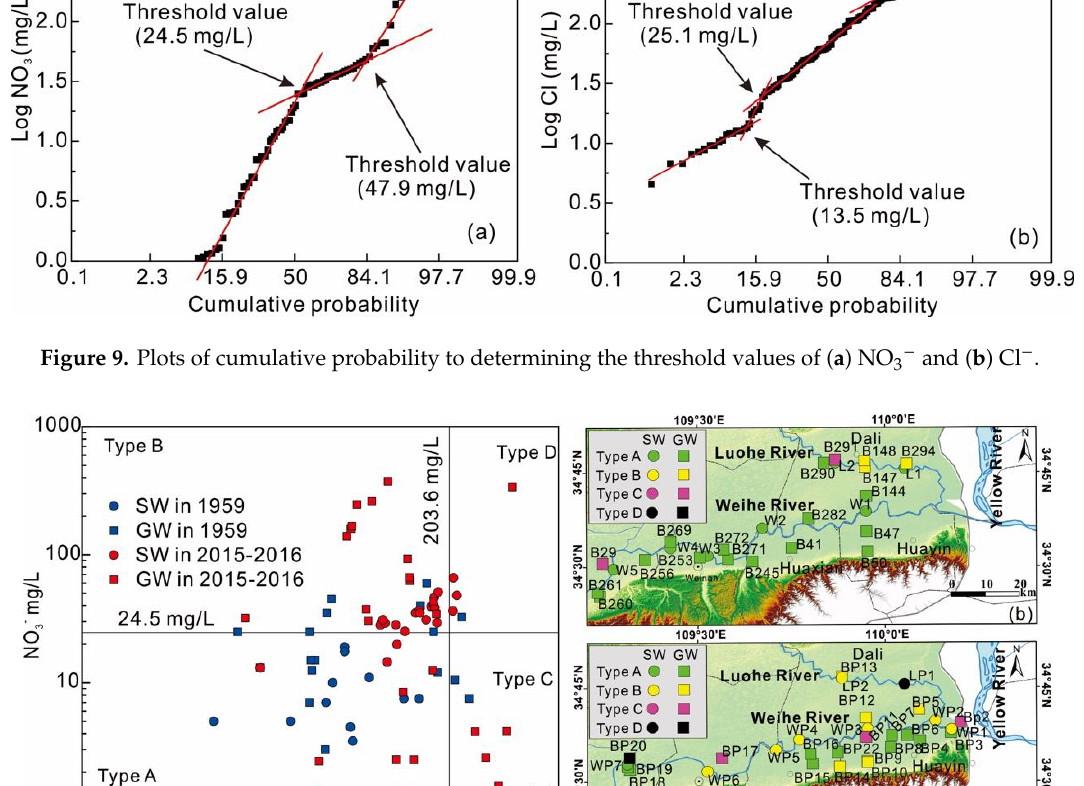
Figure 9. Plots of cumulative probability to determining the threshold values of ( a ) NO 3 − and ( b ) Cl − . Table 3. Results of water type classification.